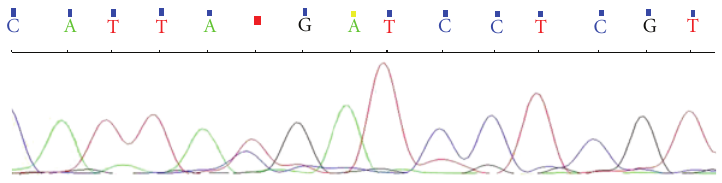
Figure 1: A search for mutations within the connexin 26 gene GJB2 showed the heterozygous c.101T → C mutation (in red in the figure) causing the substitution of a methionine residue for threonine at position 34 (p.Met34Thr).